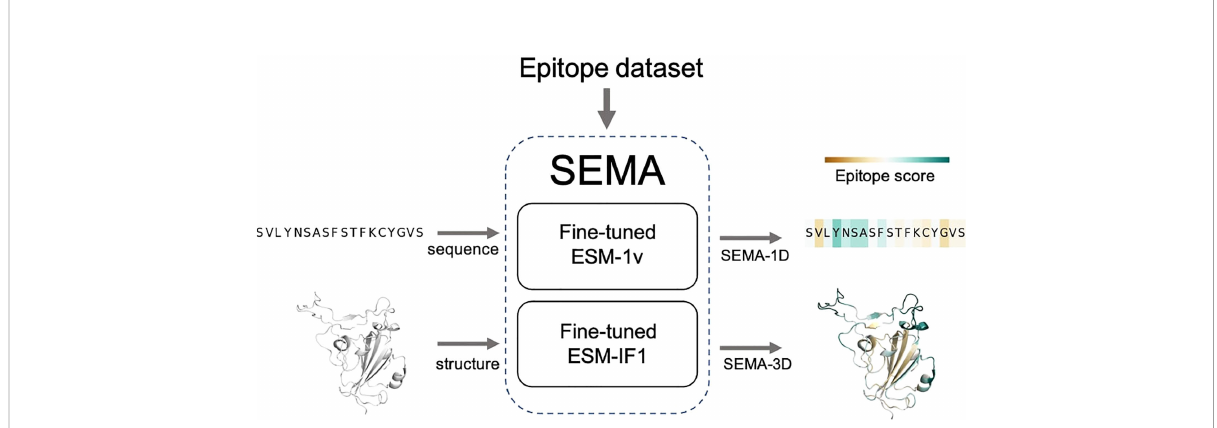
FIGURE 3 Scheme of SEMA. SEMA comprises fi ne-tuned ESM-1v (SEMA-1D) for the sequence-based and fi ne-tuned ESM-IF1 (SEMA-3D) for the structure- based prediction of